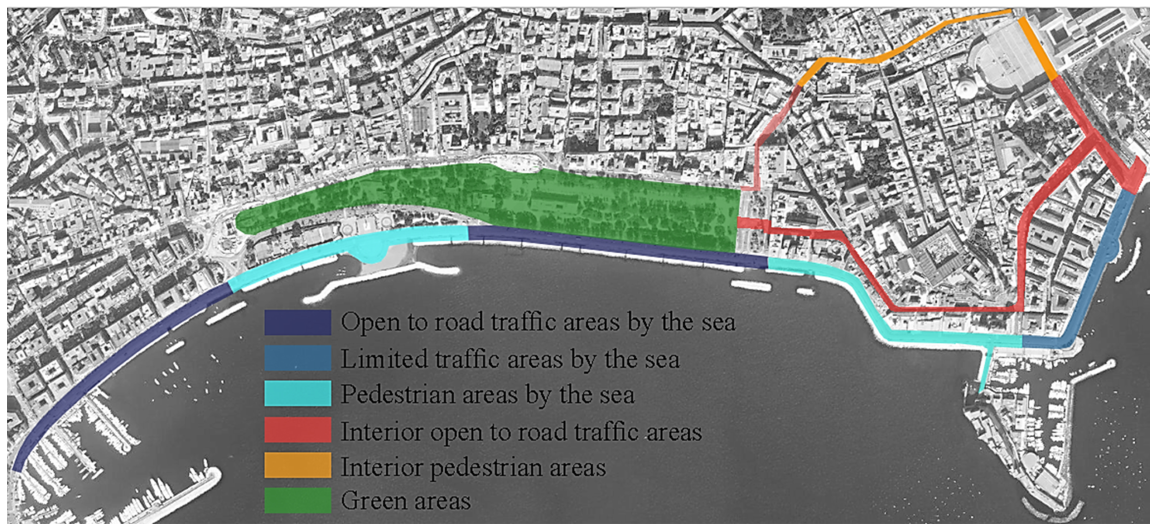
Figure 1: The selected study areas in